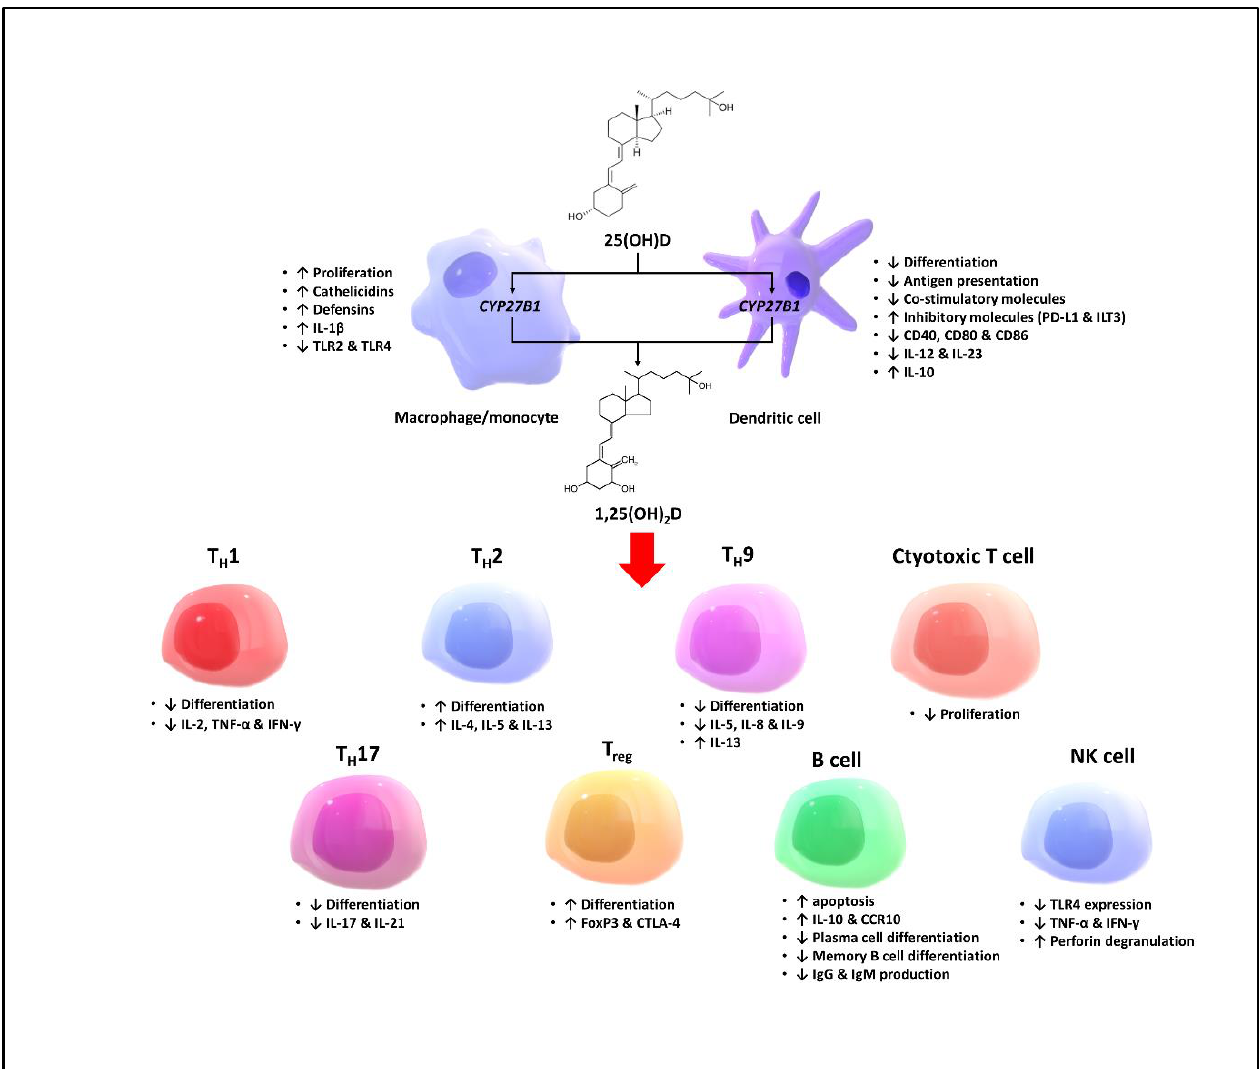
Figure 2. Effects of vitamin D on different cell types of the innate and adaptive immune systems.